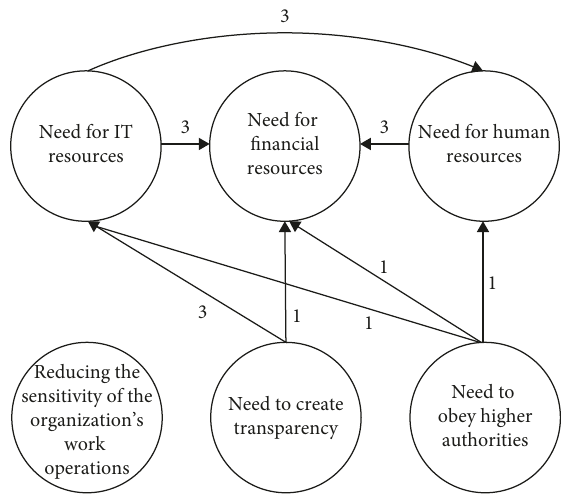
Figure 10: The direct-relation graph of